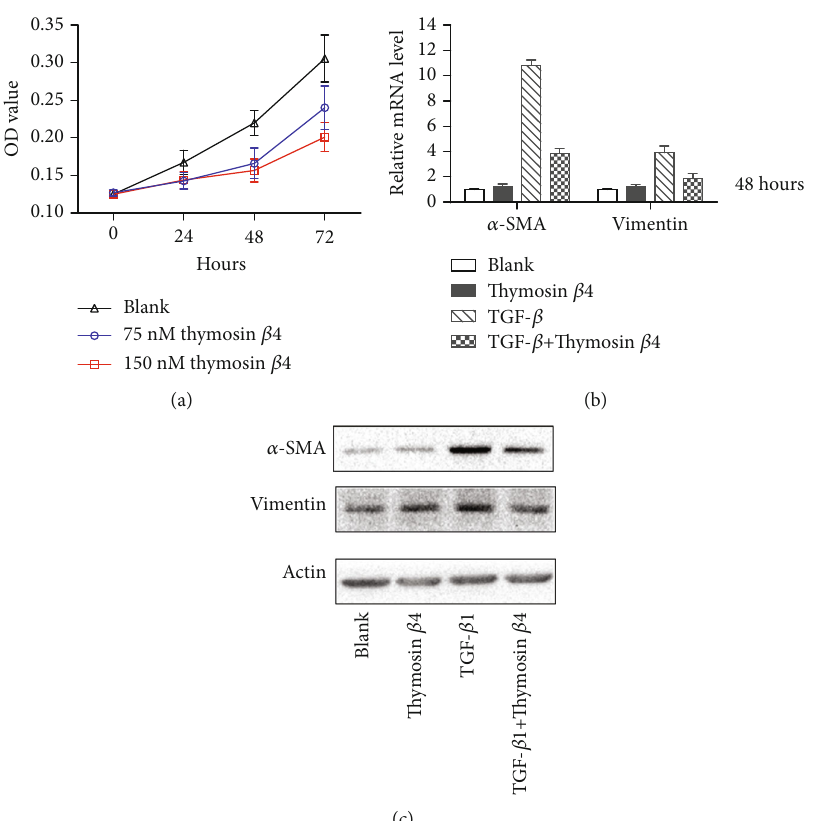
Figure 8: T β 4 inhibits myo fi broblast growth and TGF- β 1-induced activation. Development of myo fi broblast cells treated by T β 4 (75- 150nM, 12h) (a). Expression of α -SMA and vimentin in myo fi broblast cells treated by T β 4 (150nM, 12h) and/or TGF- β 1 (5 ng/mL) at mRNA (b) and protein (c)